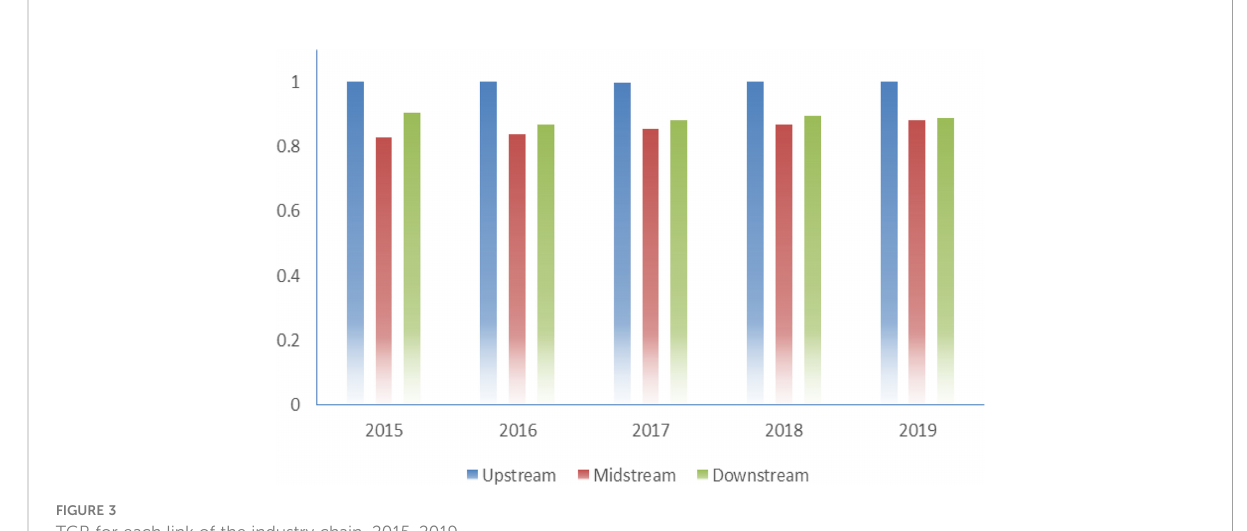
FIGURE 3 TGR for each link of the industry chain,